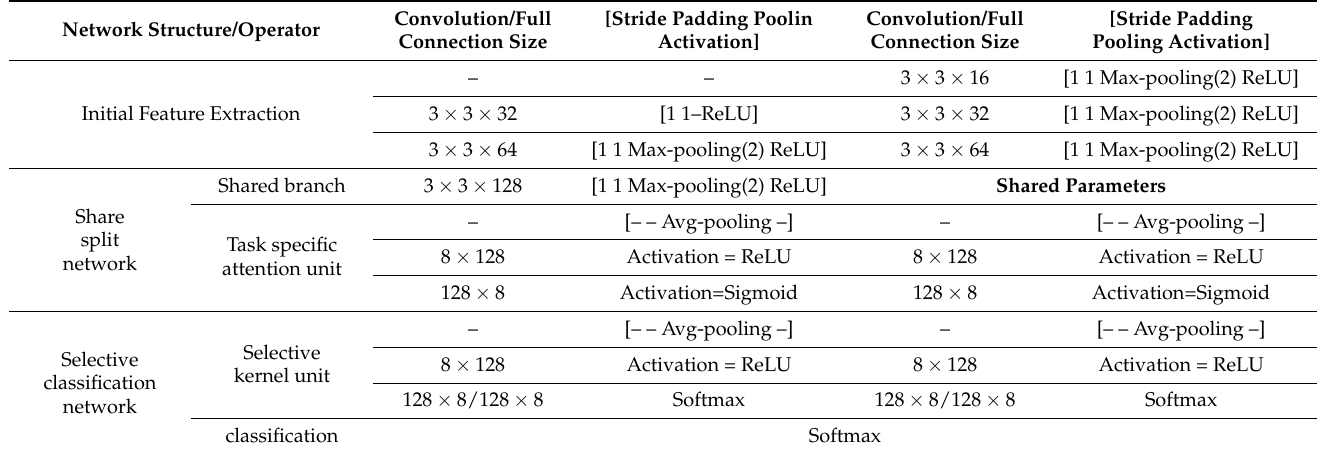
Table 1. Parameter setting of the proposed